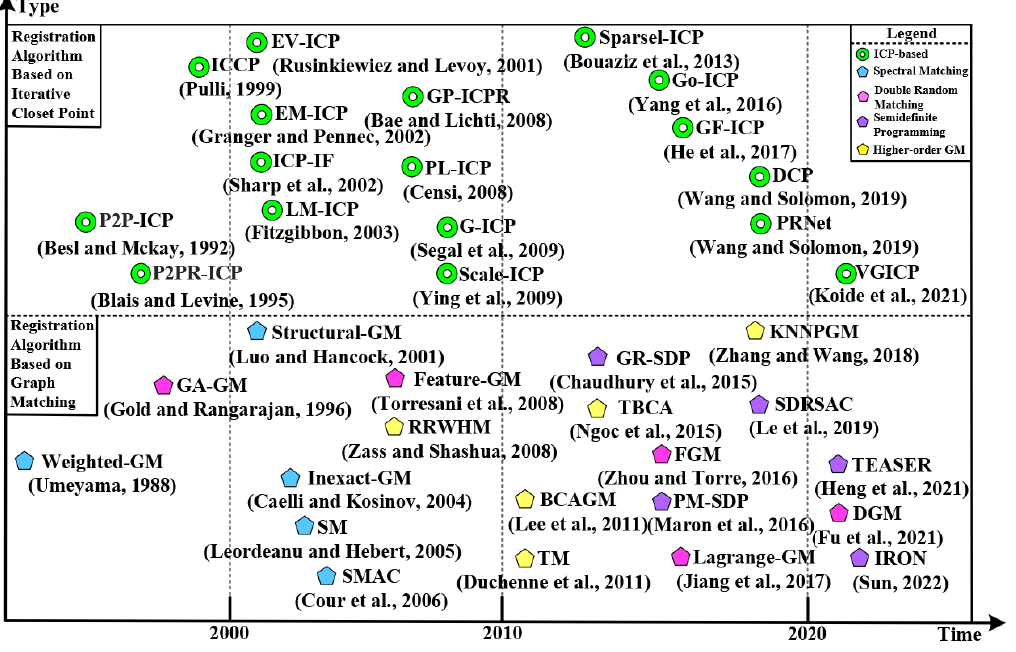
Figure 1. Chronological Overview of Registration Algorithms Based on Hierarchical Optimization [31–66].